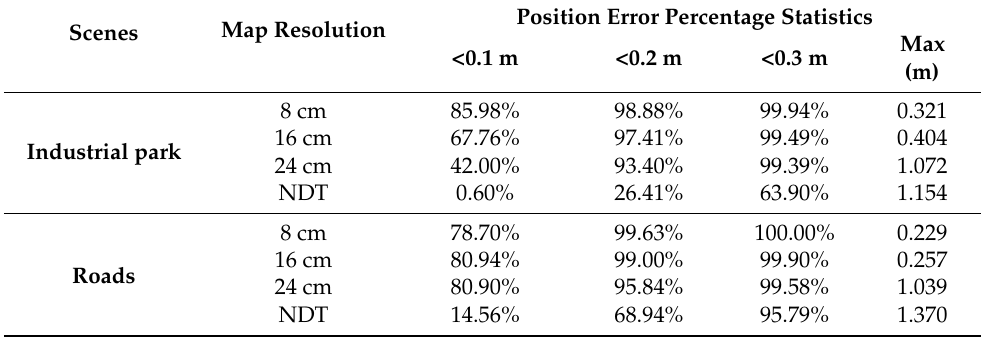
Table 5. Quantitative analysis: the percentage of positioning results better than 0.1 m, 0.2 m, 0.3 m, and max position